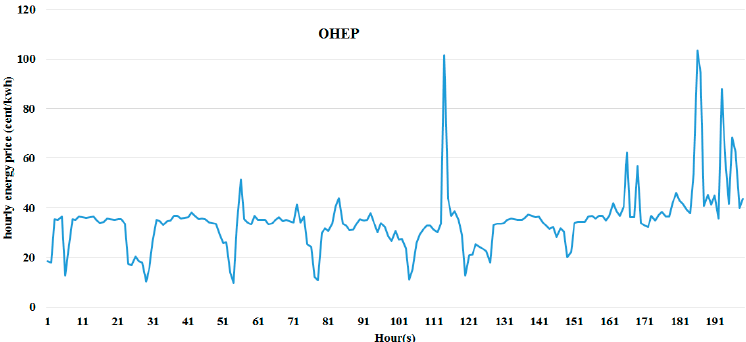
Figure 7. Hourly energy price data information (cents/kwh).